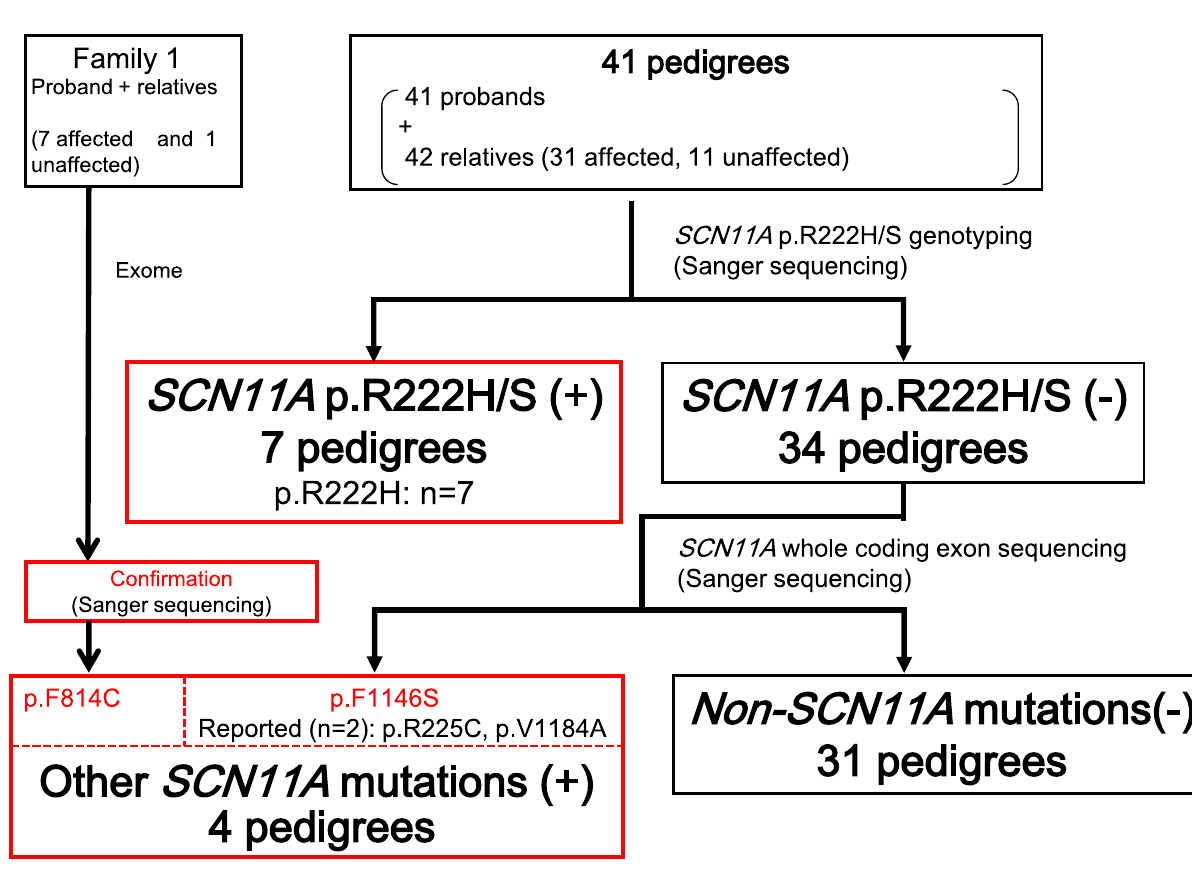
Fig 1. Scheme of SCN11A mutation screening.